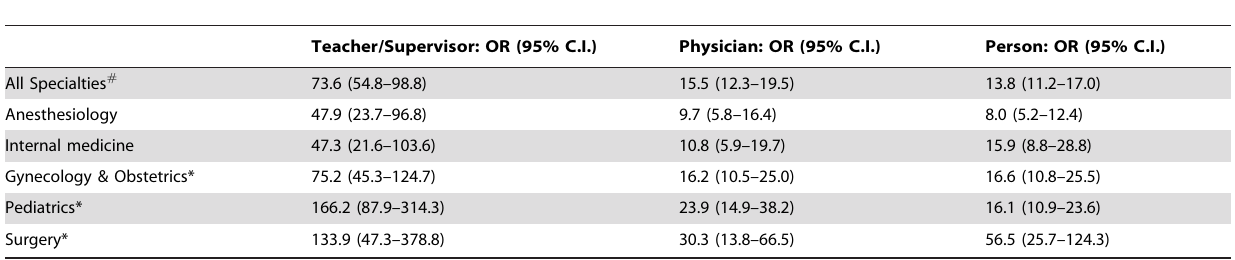
Table 3. Odds ratios (OR) for the adjusted associations between faculty’s Teaching Performance and different types of role models as seen by the